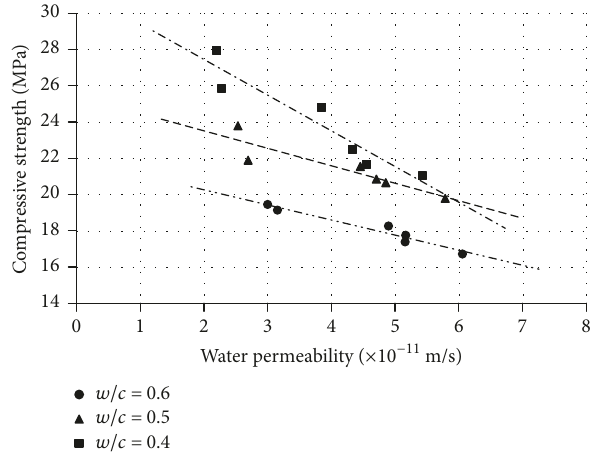
Figure3:Waterpermeabilitycoefficientwithrespecttocompressive strength of brick aggregate concrete.